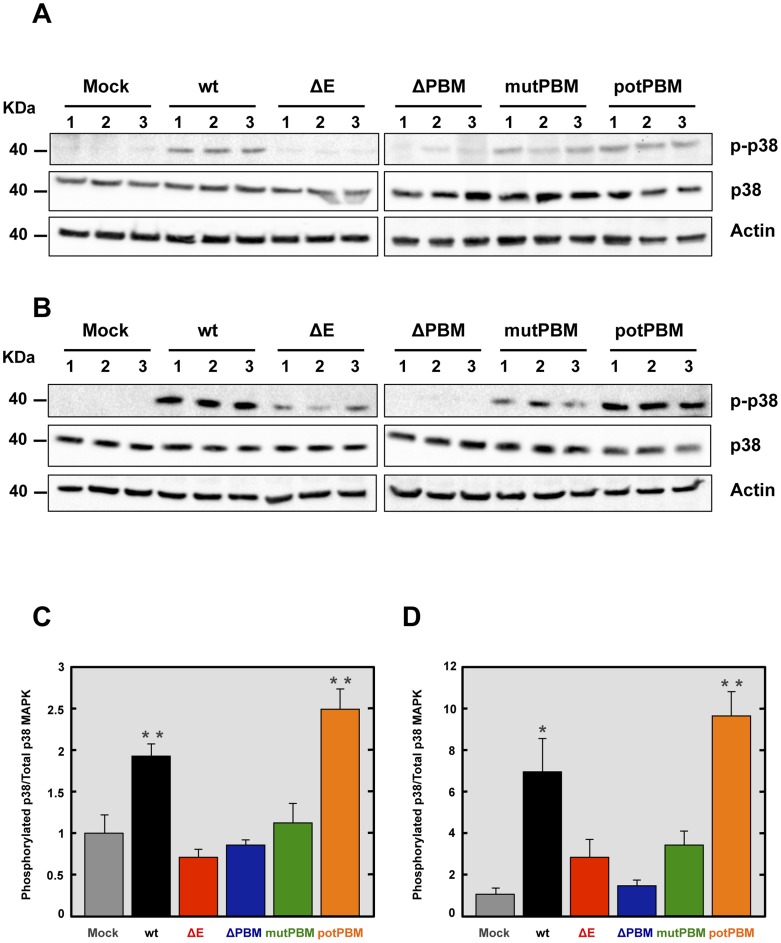
Activation of p38 MAPK in SARS-CoV-E-PBM mutants infected mice and cells.Lung proteins were extracted from infected mice at 2 dpi. (A) The active phosphorylated (p-p38) and total (p38) p38 MAPK in lungs of three infected mice per condition were evaluated by Western blot analysis. (B) The active phosphorylated (p-p38) and total (p38) p38 MAPK in Vero E6 infected cells were evaluated by Western blot analysis. (C and D) Phospho and total p38 MAPK amounts were quantified by densitometric analysis. The graph shows the phosphorylated p38/total p38 MAPK ratio in wt, ΔE, ΔPBM, mutPBM and potPBM infected mice at 2 dpi (C) or Vero E6 cells at 24 hpi (D). Error bars represent the means of three mice analyzed for each condition. Statistically significant data are indicated with one (P<0.05) or two (P<0.01) asterisks.